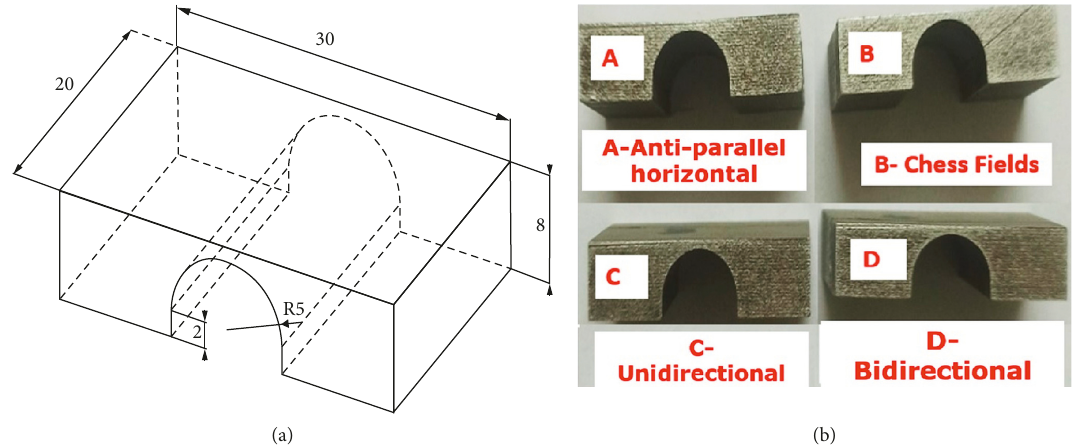
Figure 4: (a) Dimensions of the bridge construction and (b) final product from SLM.